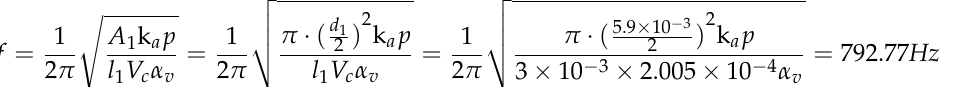
Figure 13. Marginal spectrum of vapor volume.